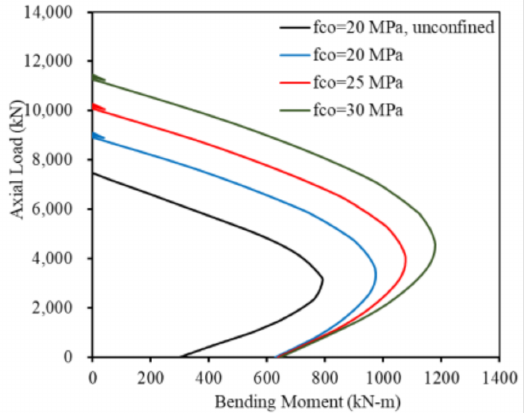
Figure 16. P-M interaction curves according to the concrete strength (S-S cross-section).